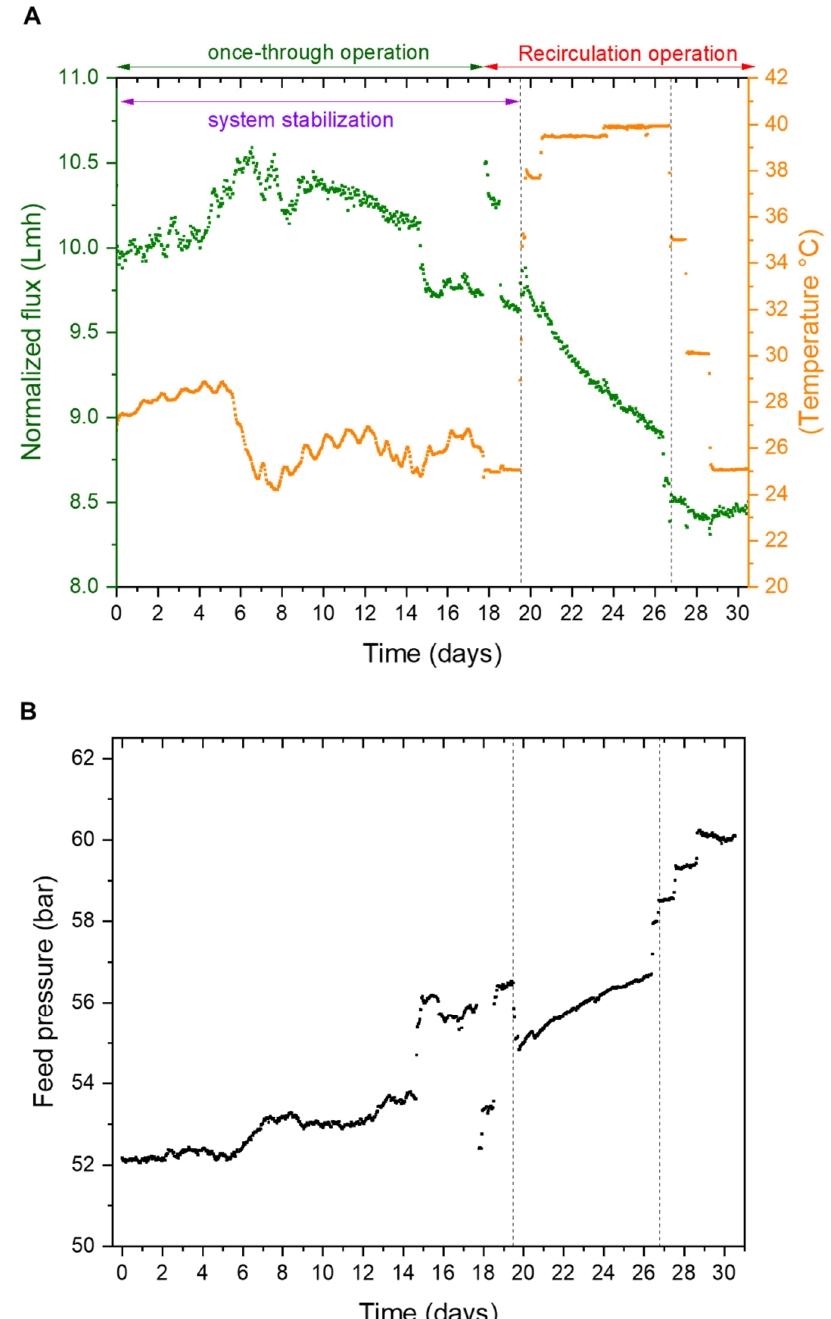
Figure 3. Operating data of the pilot test, data captured from the distributed control system (DCS). The plots ( A ) show the variation in normalized flux and ( B ) feed pressures with changes in feed temperature. The dotted vertical lines indicate the period where the feed water temperature was maintained at 40 °C.